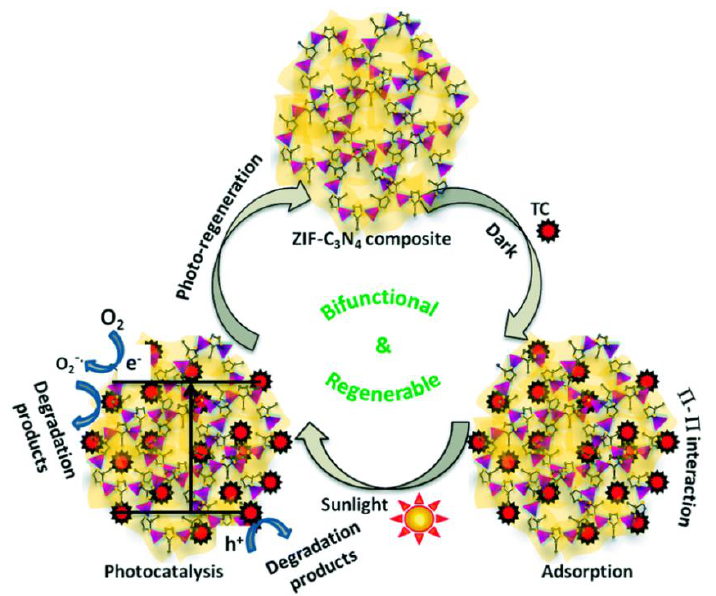
Figure 8. Schematic illustration of adsorption and photocatalytic degradation of tetracycline by C 3 N 4 -ZIF-8 bi-function composite [69]. C 3 N 4 -ZIF-8 bi-function composite